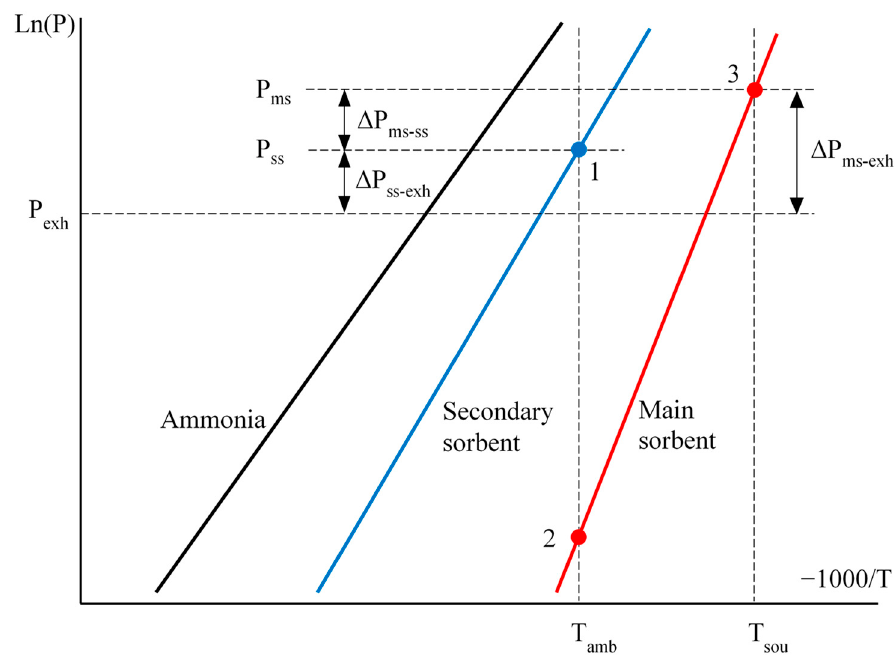
Figure 2. Clausius–Clapeyron diagram of the sorption-SCR system.